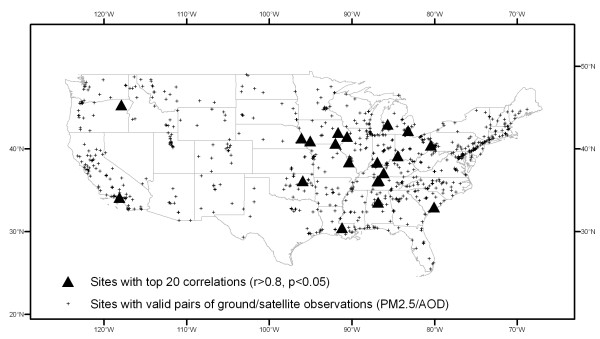
Monitoring sites with top 20 correlations of PM2.5 with AOD.